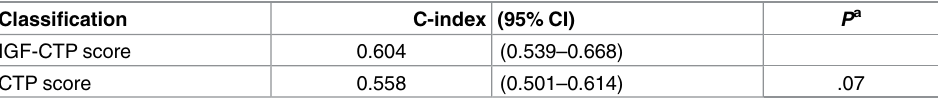
Table 3. Ranking of classification by